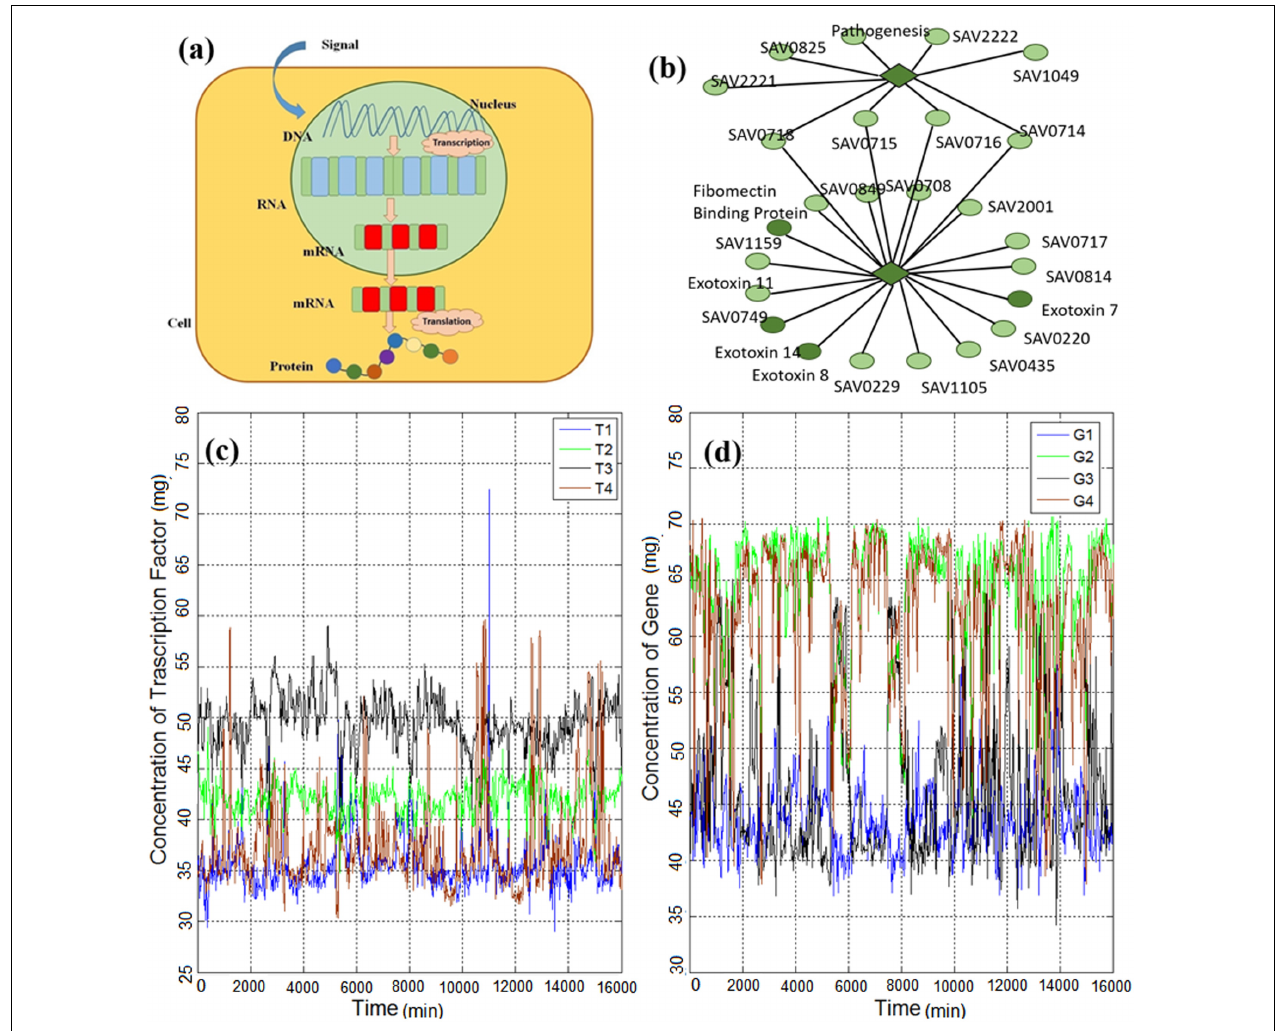
FIGURE 1 | (a) Gene expression process is initiated with the triggering of a gene in the DNA strand and continues with the generation of RNA, mRNA and, finally, the protein product. (b) Part of the gene regulatory network of Escherichia coli reported by Lockhart and Winzeler (2000), which consists of genes and transcription factors (TFs). The diamonds represent TFs and the circles represent genes. (c) Time series of TFs of E. coli obtained from Marbach et al. (2012) and explained in the methods section. (d) Time series of genes of E. coli obtained from Marbach et al. (2012) and explained in the methods